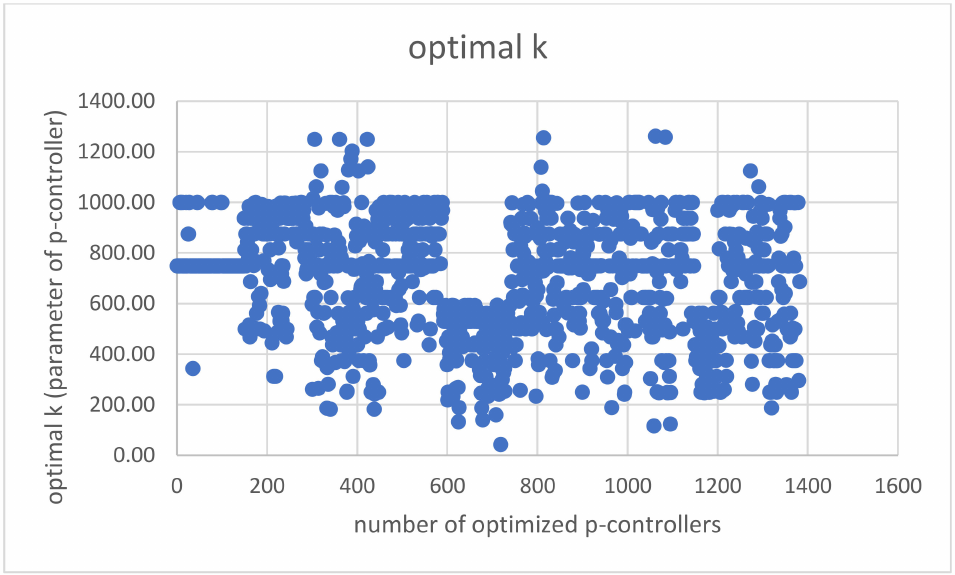
Figure 11. Optimal controller parameter k of p-controller (Supplementary